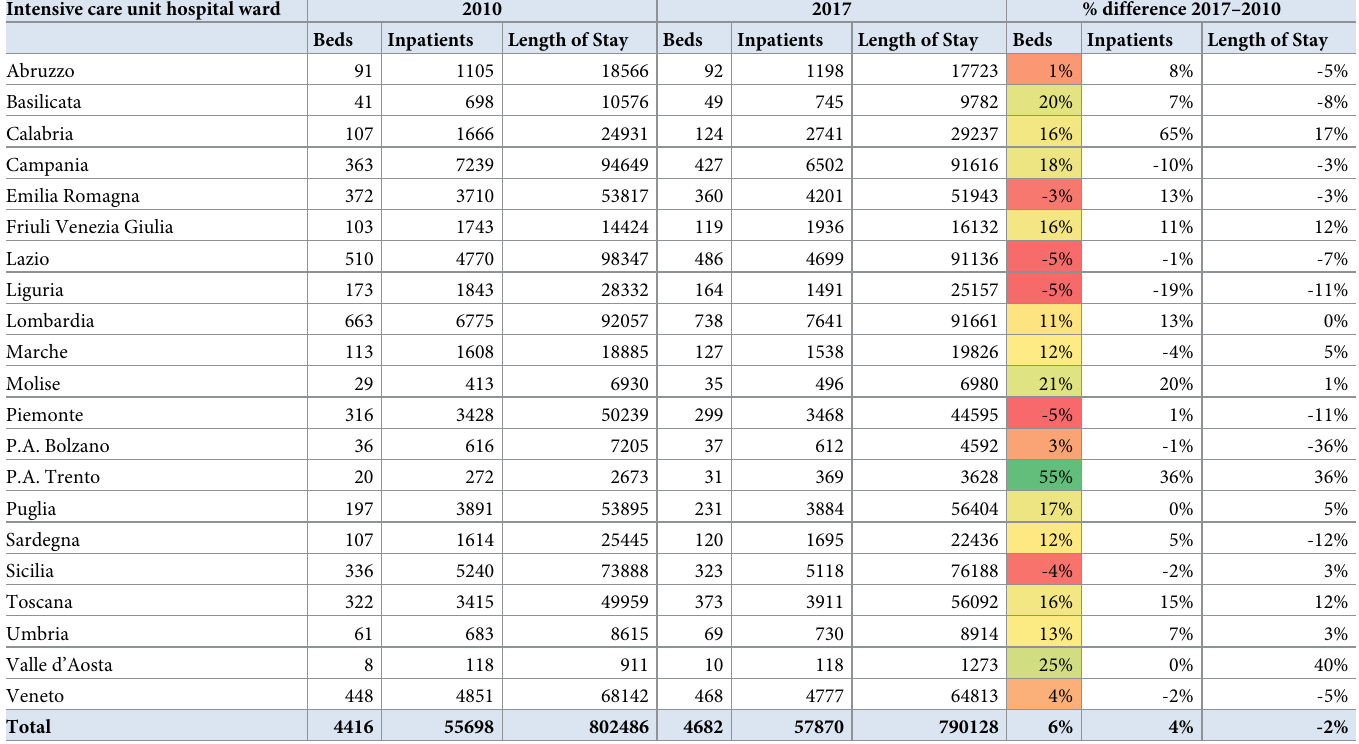
Table 2. Number of hospital beds, hospitalization and length of stay in the years 2010 and 2017 in the intensive care units highlighting the differences in each Ital- ian region. Intensive care unit hospital